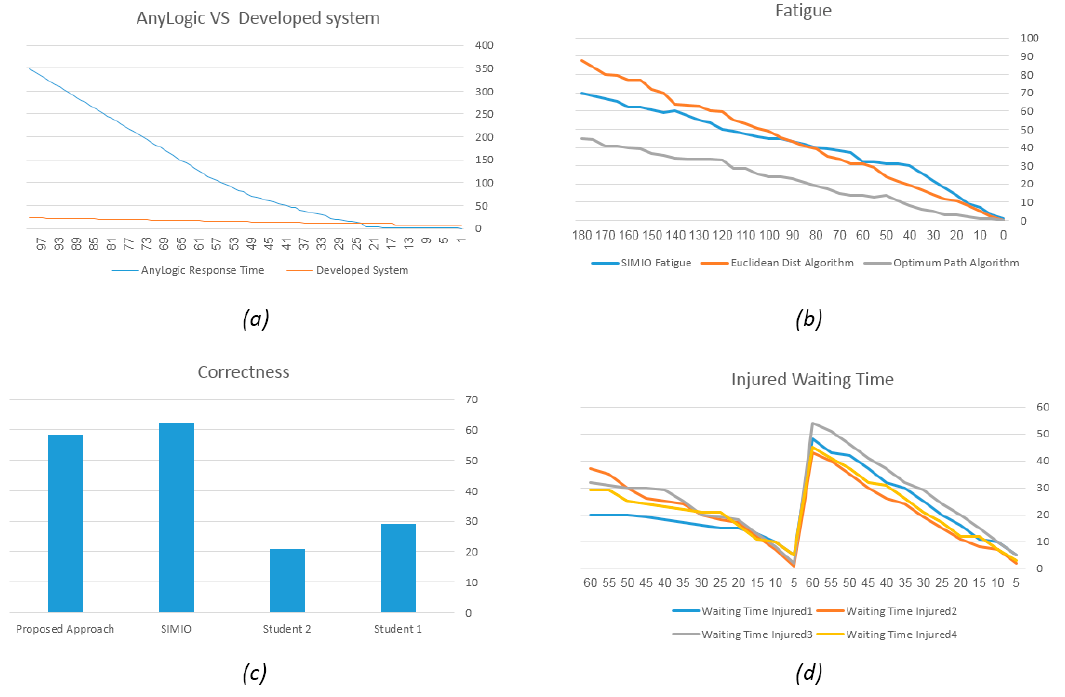
Figure 13. ( a ) System response time in AnyLogic and developed system; ( b ) agent fatigue; ( c ) number of correct choices; ( d ) Compare total waiting time of injured objects in two cases.